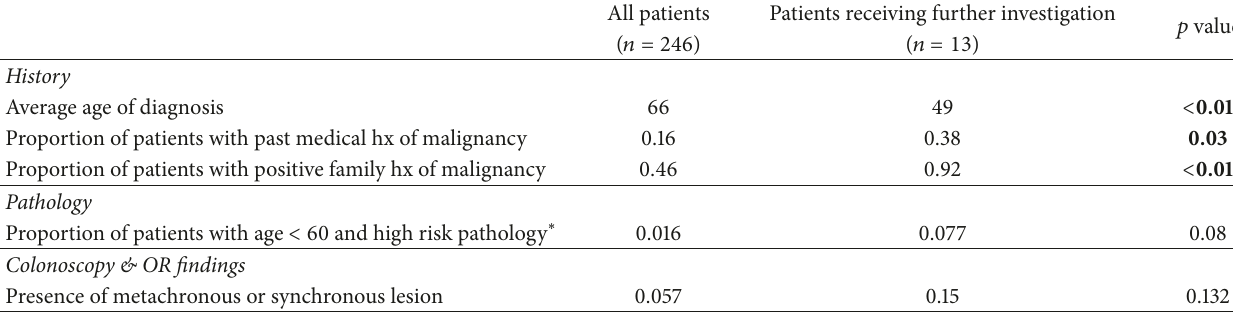
Table 3: Characteristics of patients who received further investigation compared to all